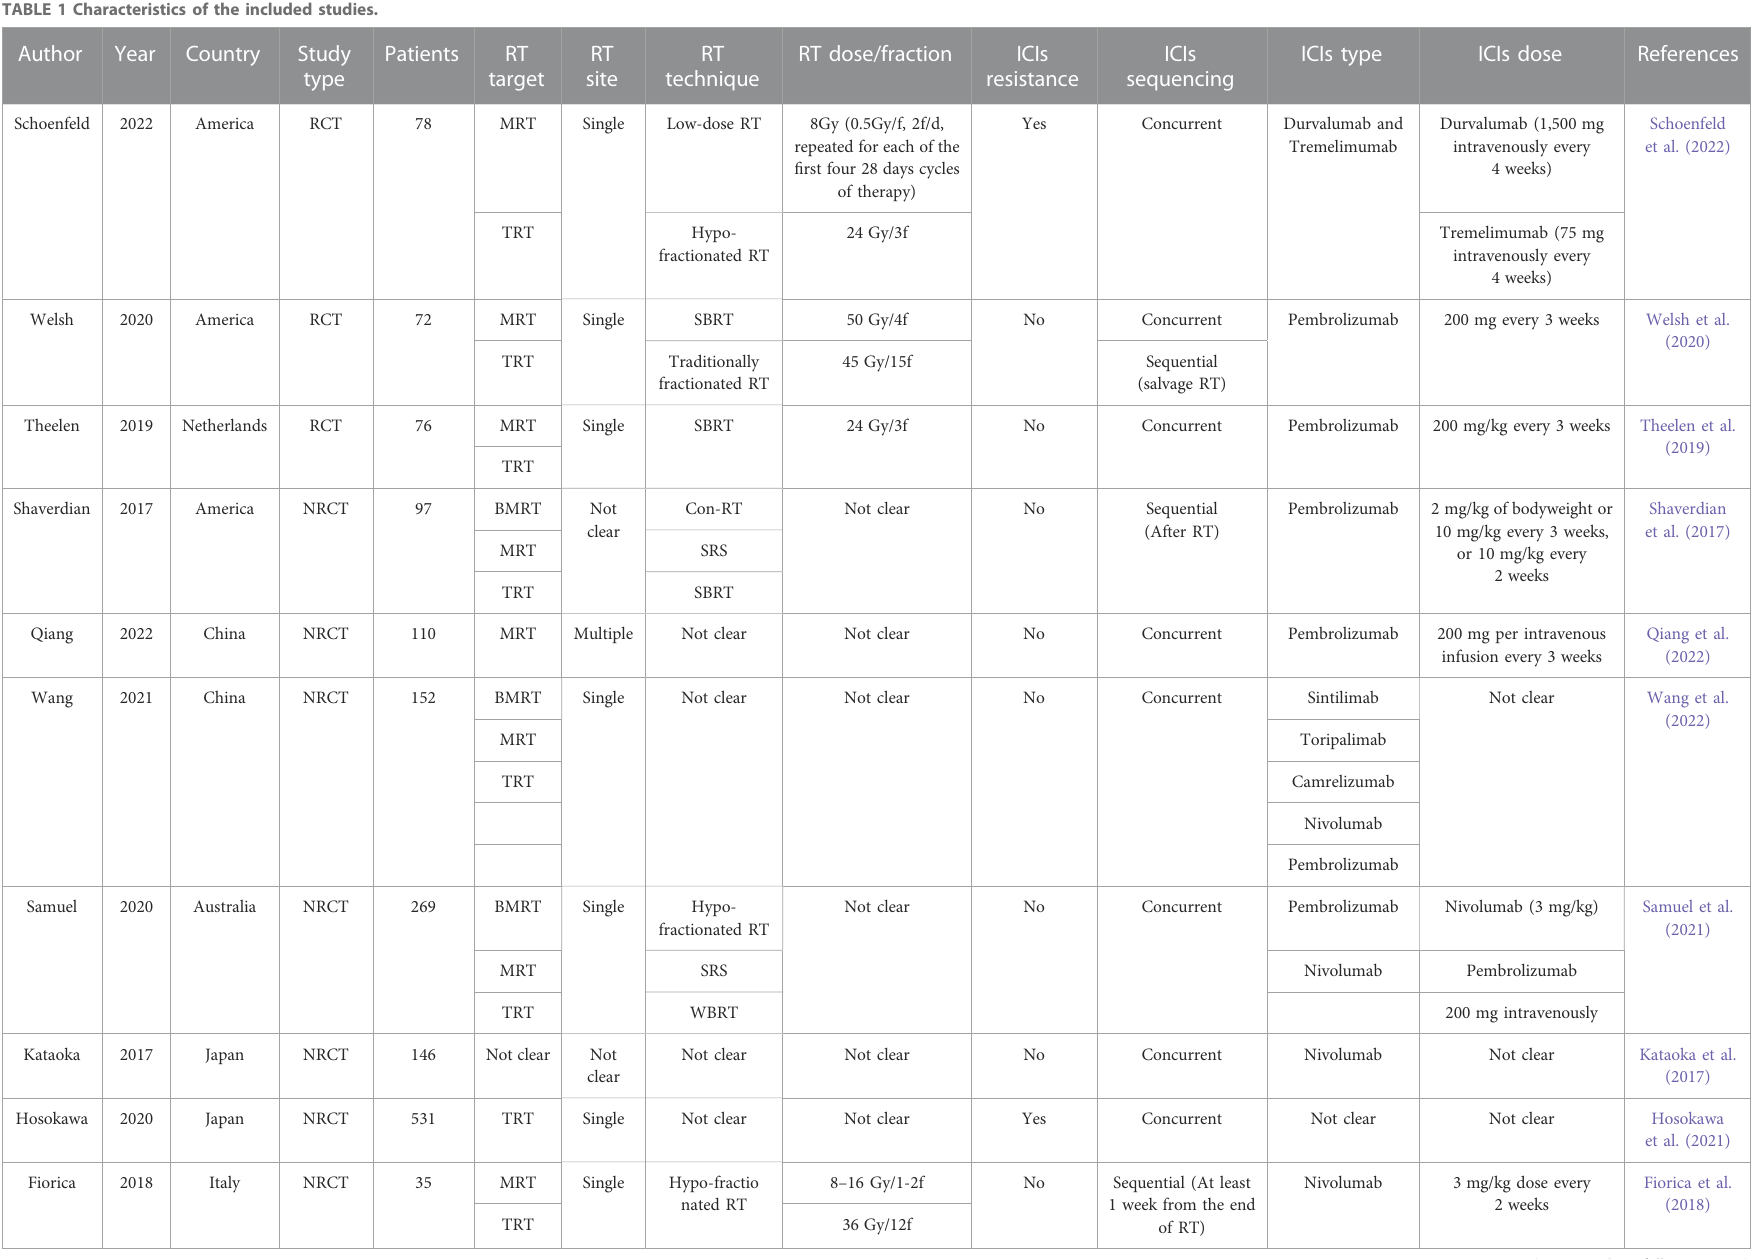
TABLE 1 Characteristics of the included